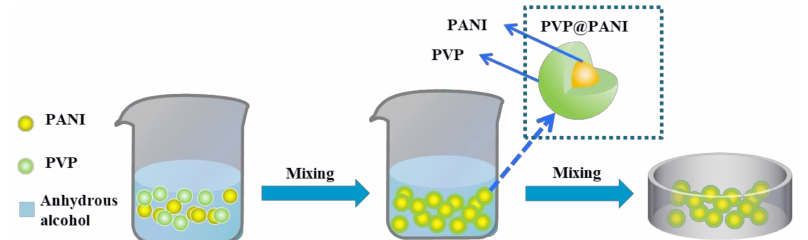
Figure 1. Schematic illustration for the preparation of PVP@PANI.